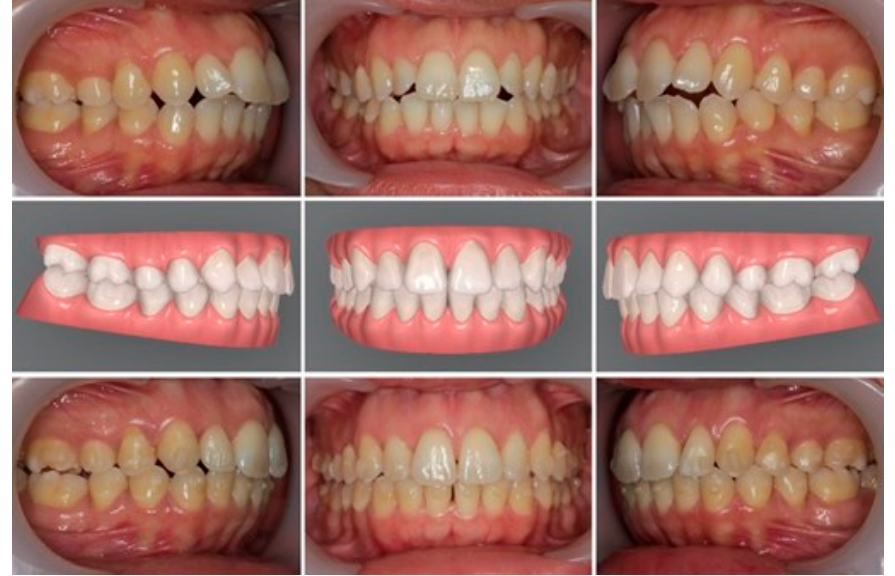
Figure 1. Representation of one of the cases included in the questionnaire; ( top ) pretreatment intraoral photographs; ( middle ) digital simulation (ClinCheck ® ) at the end of the first sequence of the aligners; ( bottom ) intraoral photographs after the first sequence of